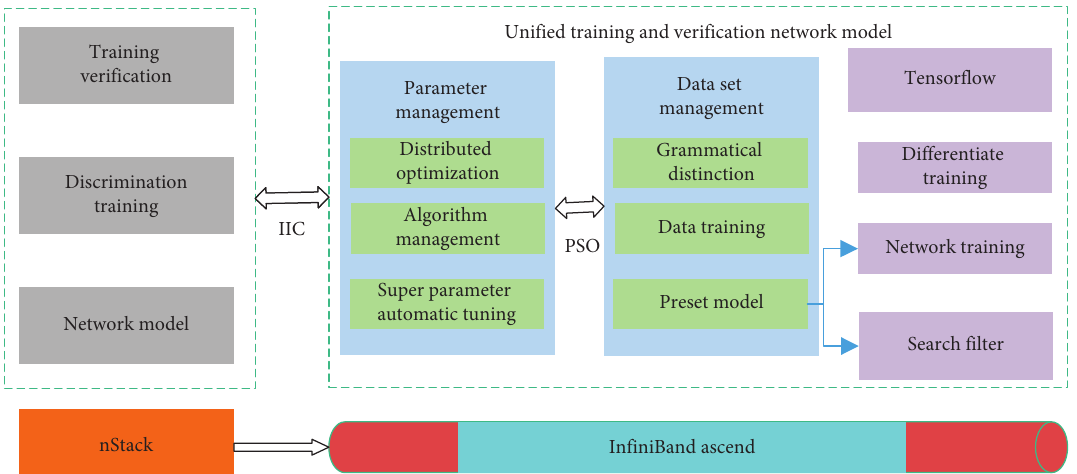
Figure 2: Network Model architecture diagram of English Grammar discriminative